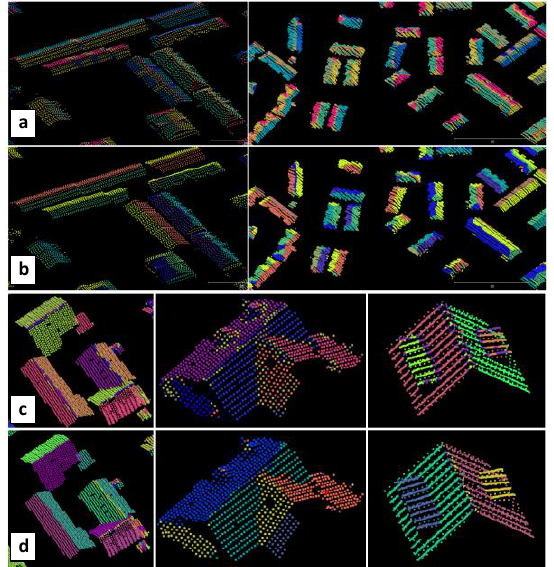
Figure 6. Examples of the initial watershed segmentation (a, c) and GCO (b, d) results for roof plane segmentation of the Bloomington (a,b) and Vaihingen (c,d) datasets.